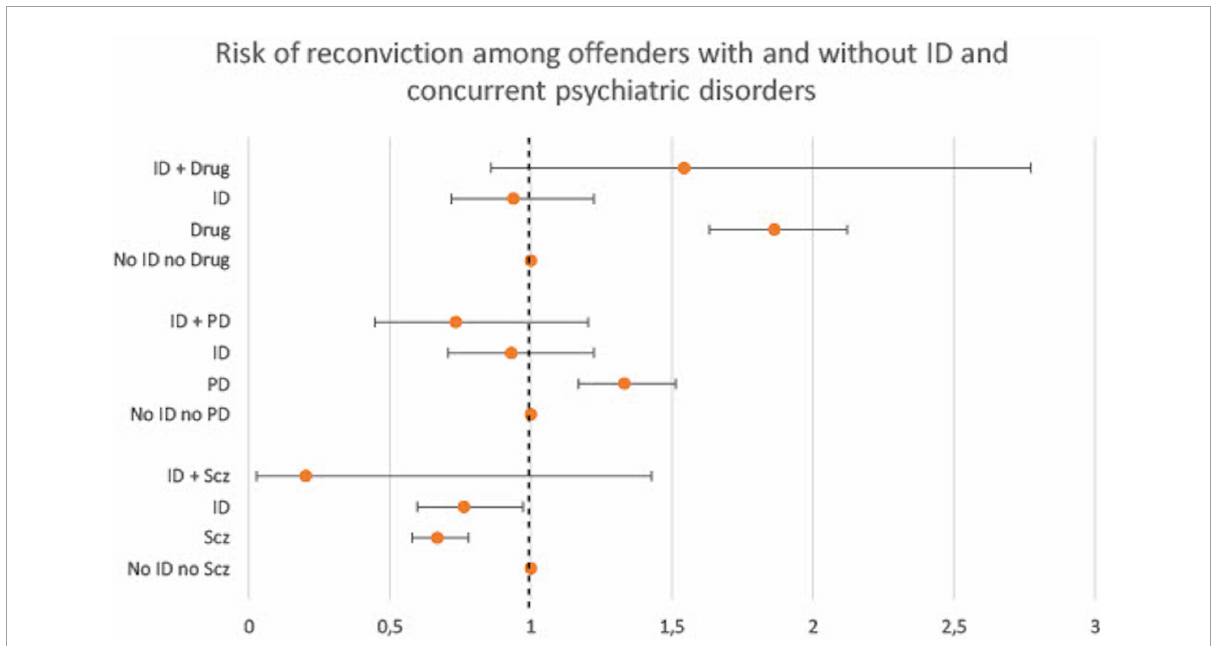
FIGURE3 Cox proportional hazard ratios (with 95% CI) for criminal recidivism associated with clinical variables among offenders with and without ID. Reference category for each group are offenders with neither ID nor the clinical variable (drug use disorder, personality disorder or schizophrenia, respectively). Drug, Drug use disorder; PD, Any personality disorder; Scz,